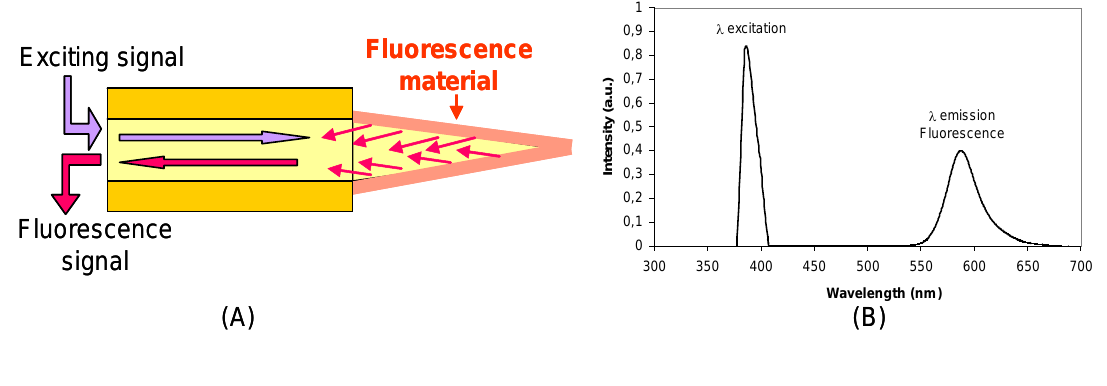
Figure 19. (A) Reflection fluorescence sensor based on a tapered end fiber. (B) Spectral response from a sensor based on fluorescence. The reflected optical power of the excitation light and the fluorescent signal emitted by the sensing material are monitored by a spectrometer. It is desirable that the fluorescence wavelength is located as far as possible from the excitation one - this would be high Stokes shift